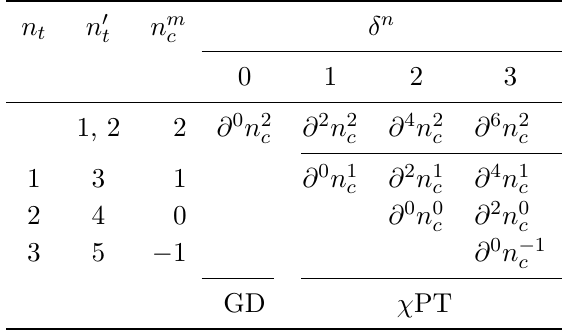
Table 8. Impact of flavour traces on the δ -counting of an operator. n t counts the number of flavour traces in operators without four-quark current insertions, while n 0 in operators with four-quark insertions. Note that m = 2 − n operators proportional to n 2 are only possible in the modified four-quark counting scheme c